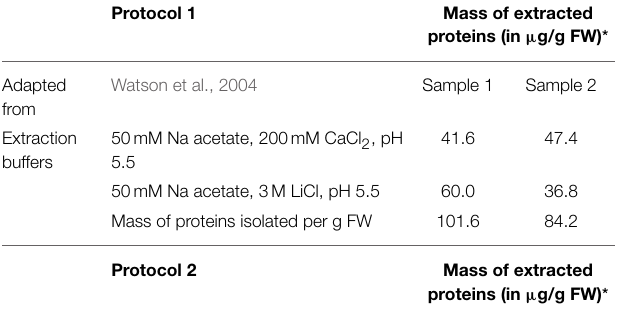
TABLE 1 | Amount of proteins extracted by fraction and by protocol. Protocol 1